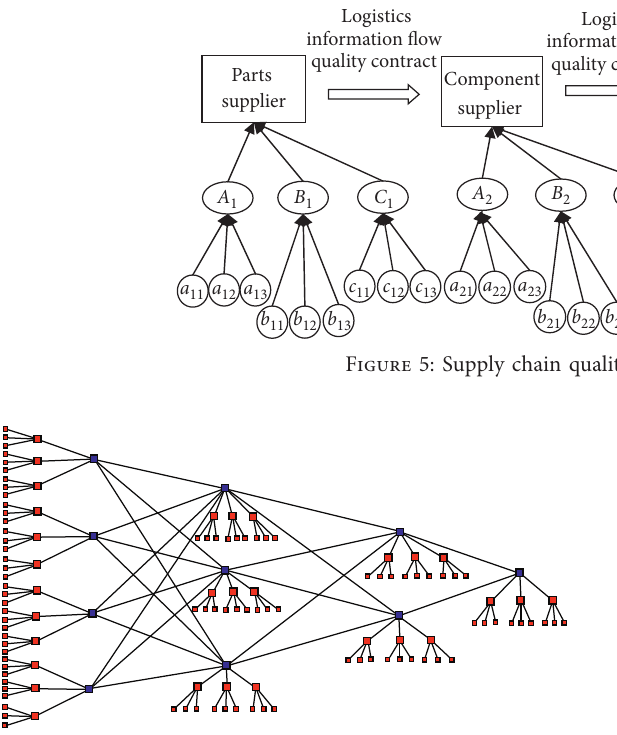
Figure 6: Quality risk propagation